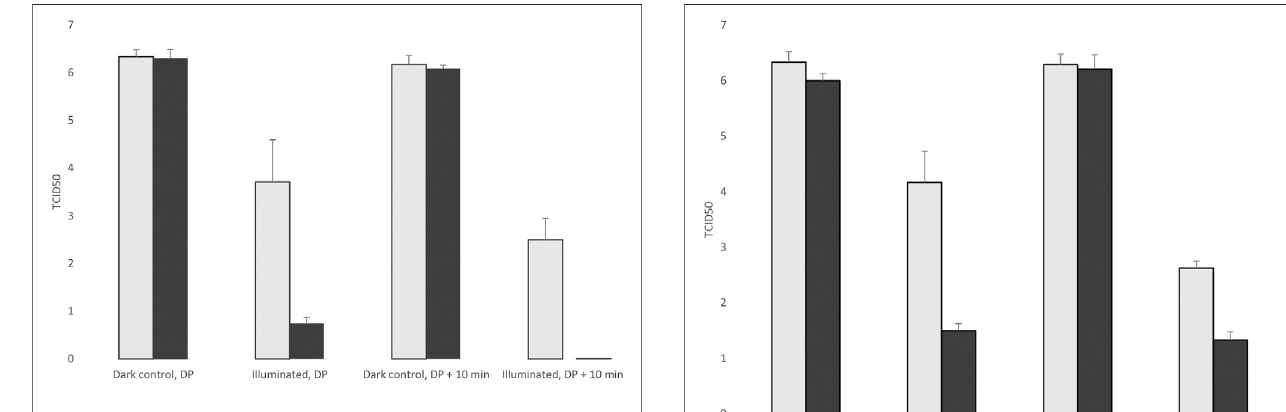
FIGURE7| Evaluation ofthe virucidal effect ofthephotoreactive surface at room temperature. DP: Desiccation point. TABLE1| TheTCID50valuesinthreereplicates,surfaceswereincubatedatroom temperature.